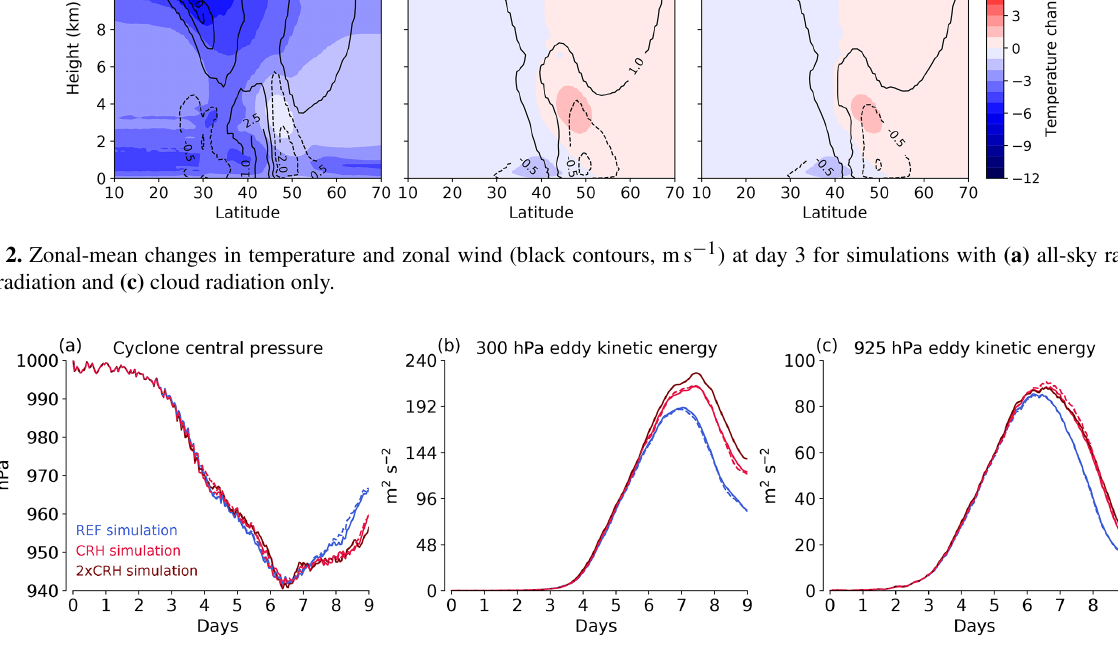
Figure 3. Evolution of (a) cyclone central pressure and eddy kinetic energy at (b) 300hPa and (c) 925hPa for simulations with no radiation (REF), cloud-radiative heating (CRH) and cloud-radiative heating increased by a factor of 2 (2xCRH). The dashed lines show additional simulations that use the two-moment instead of the one-moment microphysical